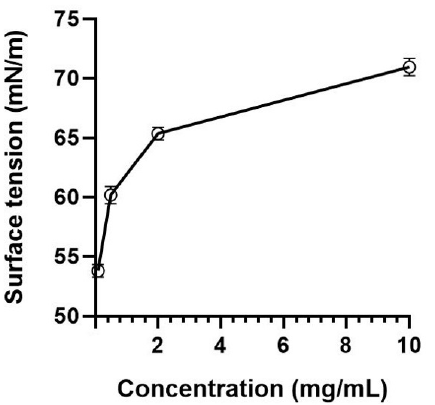
Figure 4. Surface tension of mucilage extracted from Corchorus olitorius L.